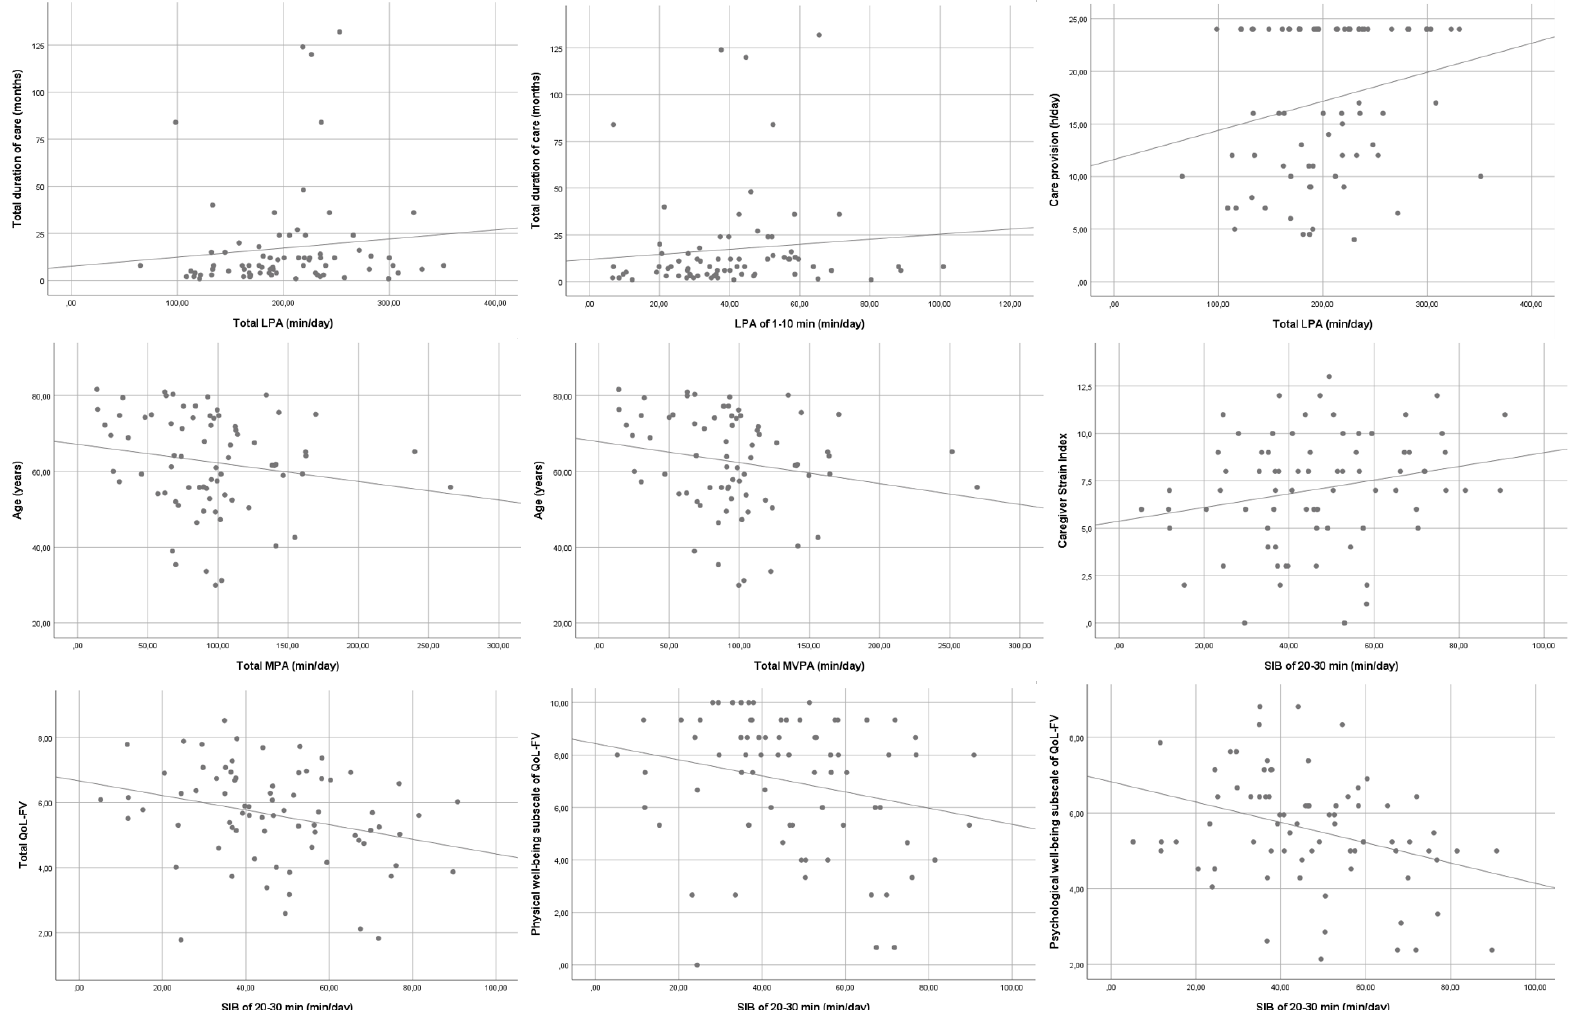
Figure 1. Significant bivariate associations.